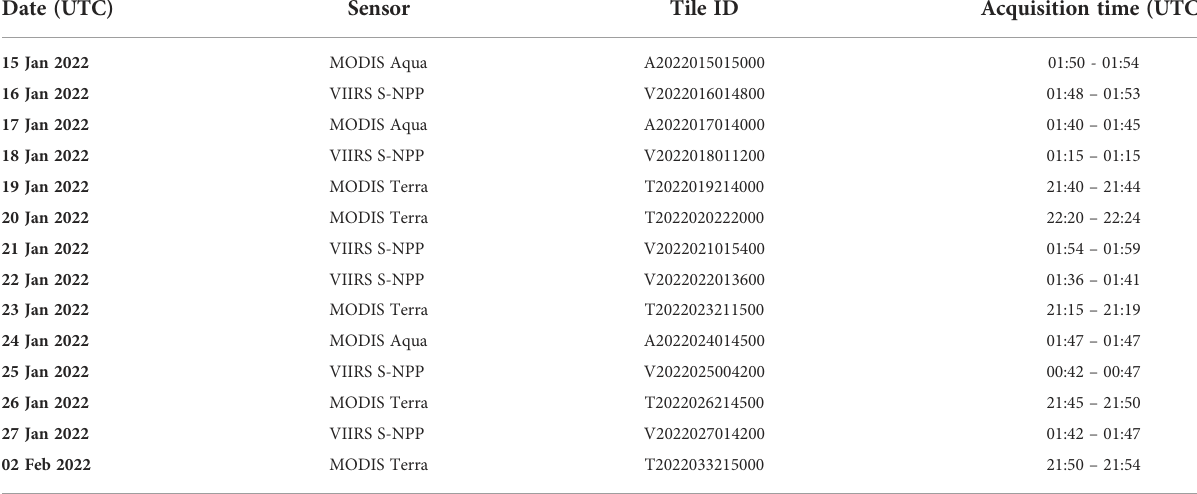
TABLE 1 List and acquisition period of L2 MODIS and VIIRS tiles used for this